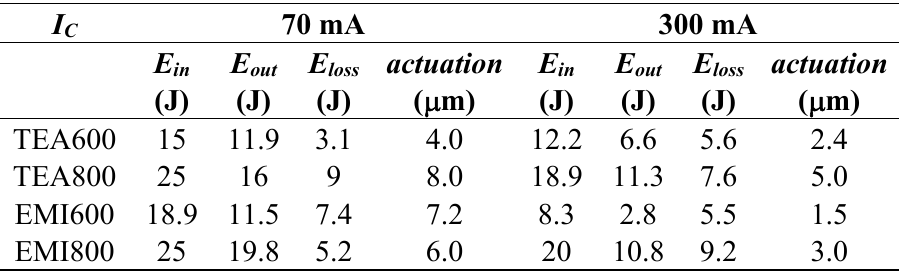
Table 4. Electrical energies (J) and maximum actuation of the linear actuators ( μ m) at different amperages of the charge-discharge current ( Δ U = 3.0